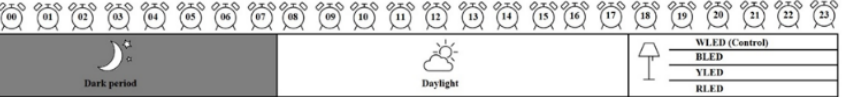
Behavioural Classification